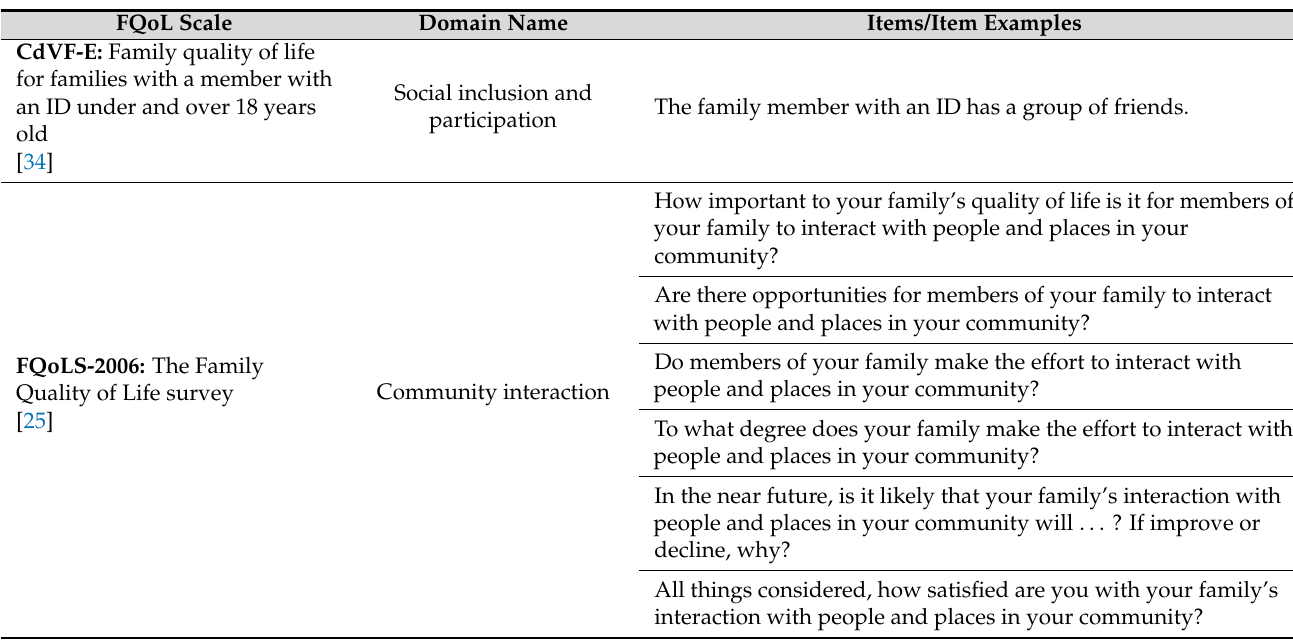
Table 9. Items/item examples considered in the domain of community participation within each FQoL scale.